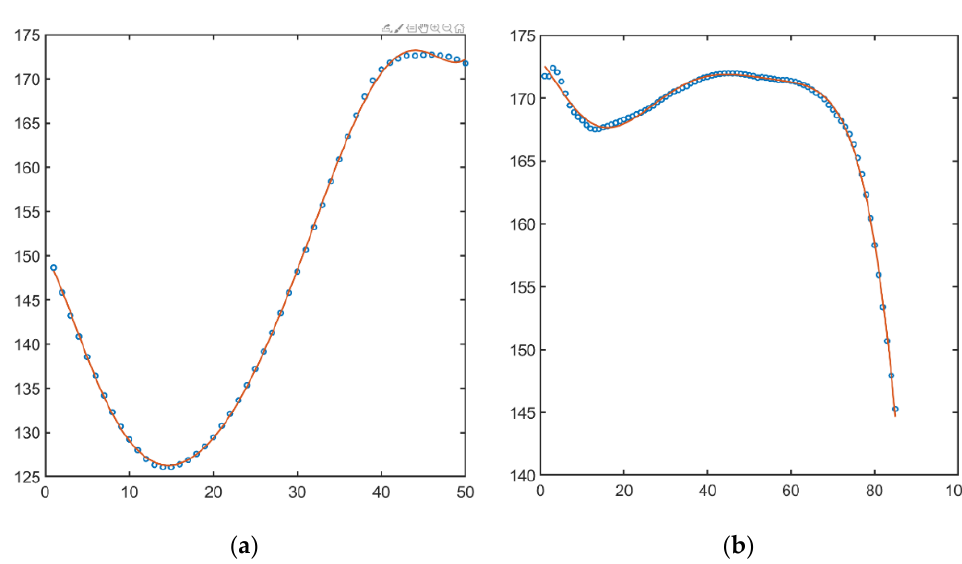
Figure 4. Change in the knee angle in swing phase ( a ), stance phase ( b ).